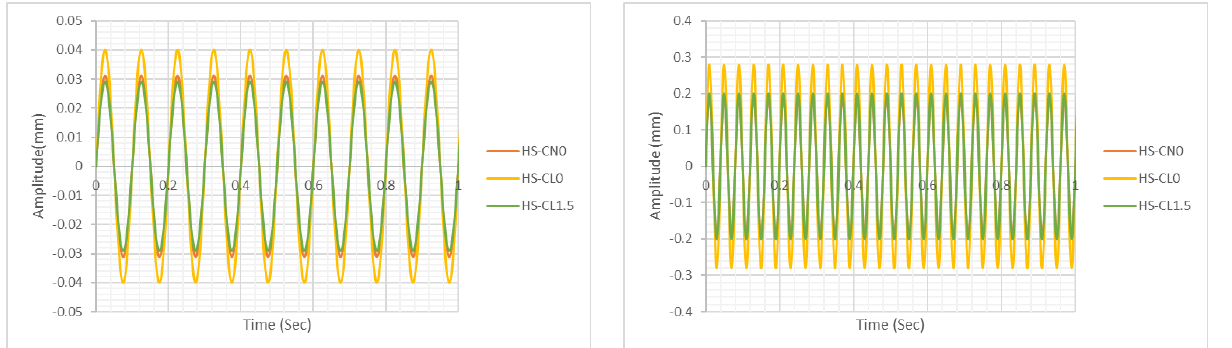
Figure 6: Vibration-time history under harmonic load with 10Hz frequency